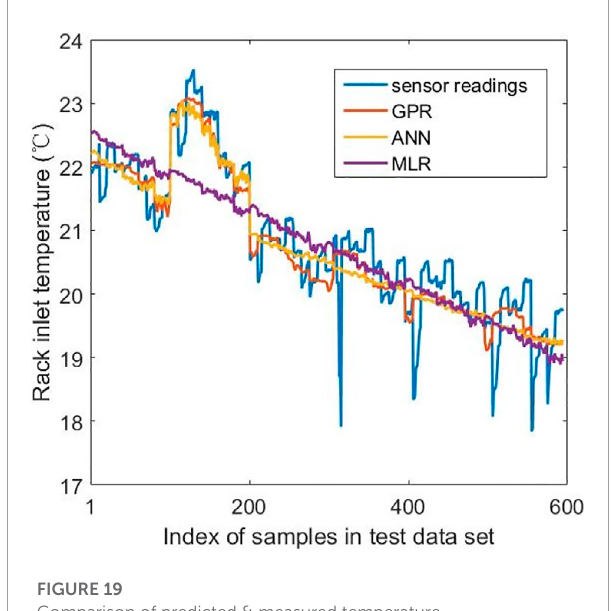
FIGURE 19 Comparison of predicted & measured